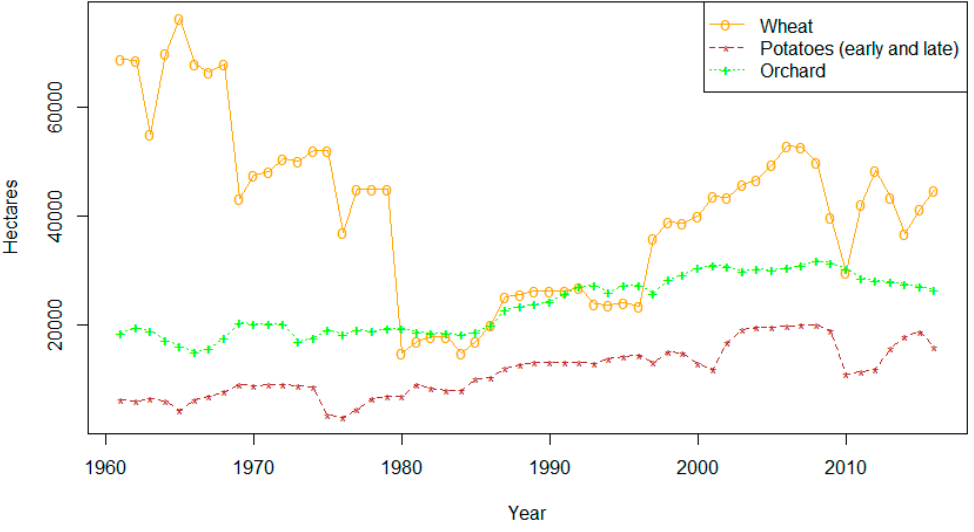
Figure 9. Increasing harvest areas in Lebanon: 1960–2016 [34].